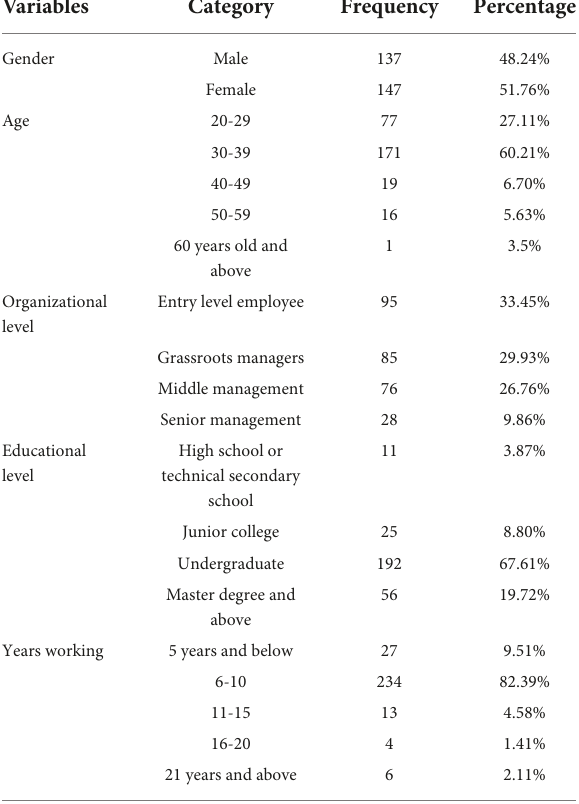
TABLE 1 Sample distribution of demographic